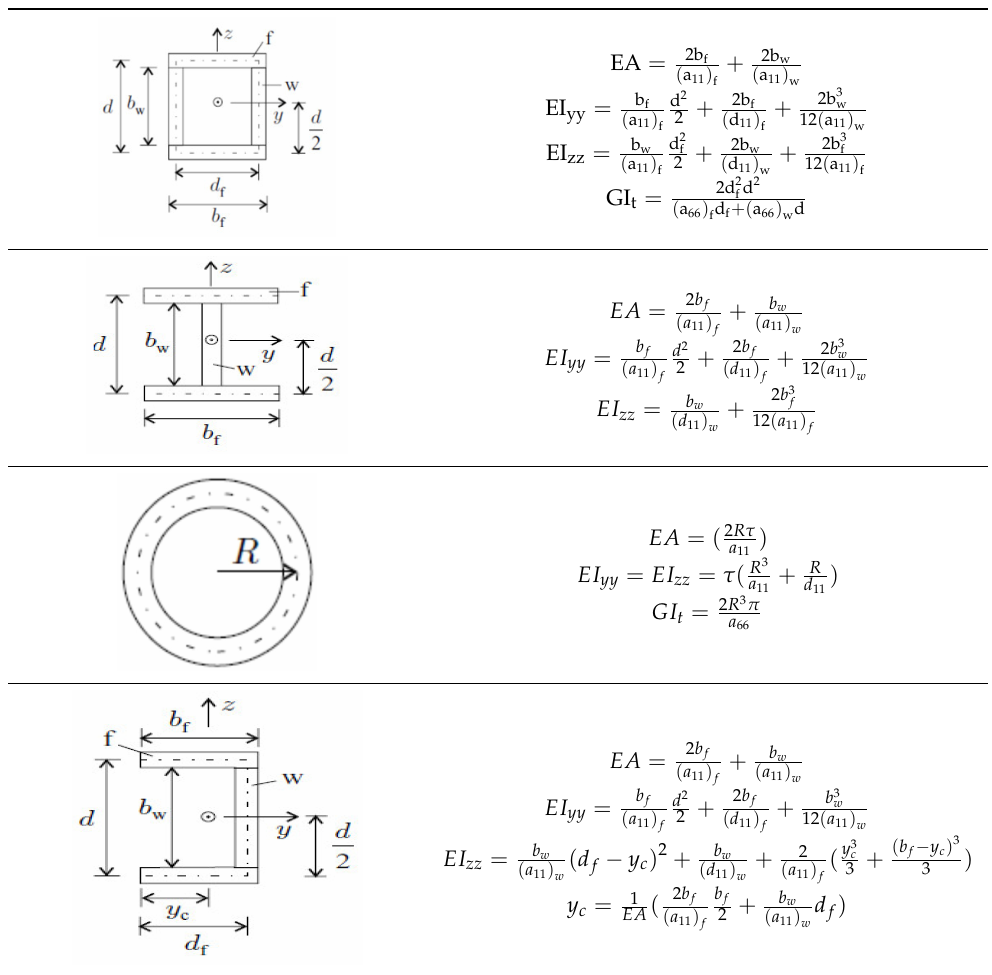
Table A1. Equivalent axial, bending, and torsional stiffnesses [19].